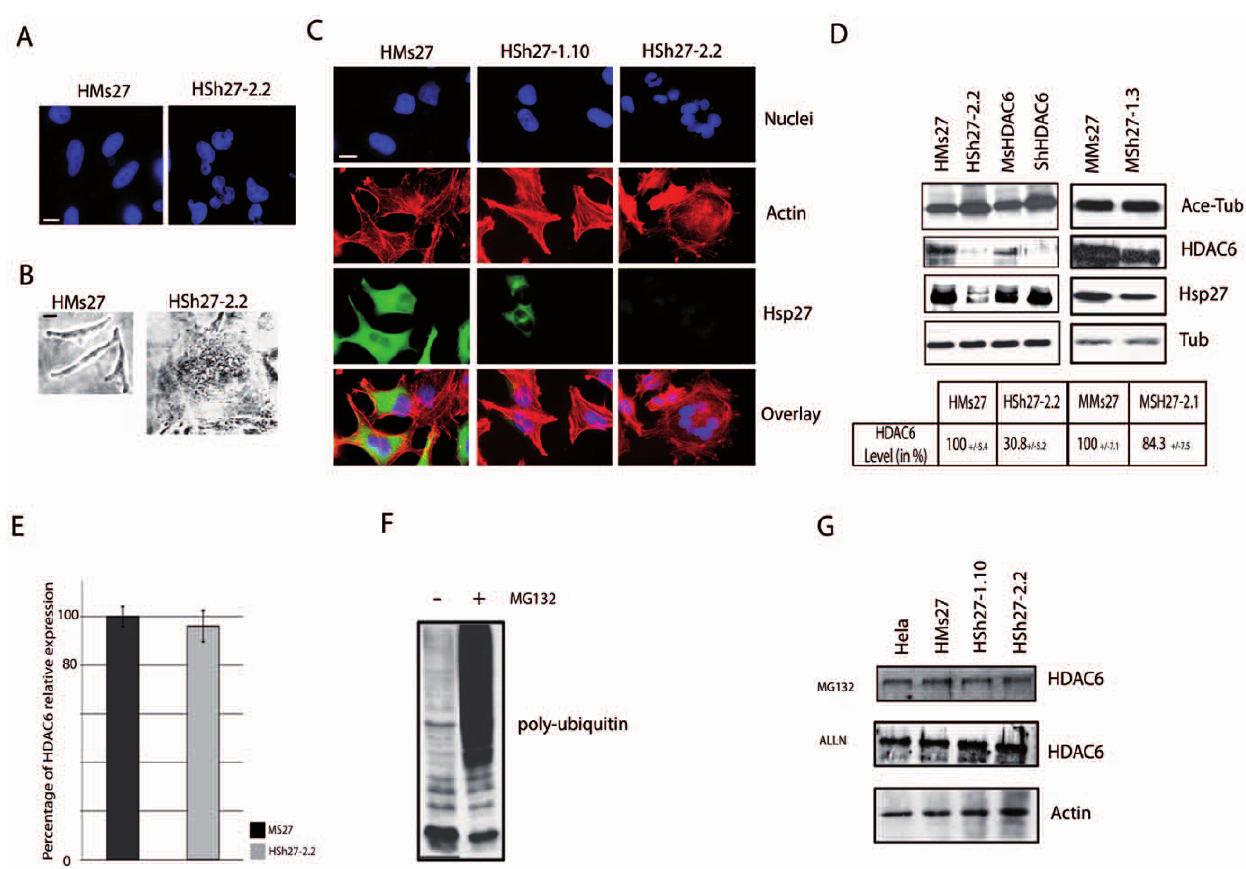
Figure 3. HDAC6 is degraded in Hsp27 deficient cell lines. A , photographs of nuclei of Hsp27 depleted HeLa cells stained by Hoechst. B , phase contrast pictures of a depleted HeLa clone showing a giant cell containing more than twenty nuclei. Bar=10 m m. C , Fluorescence photomicrographs analysis of Hsp27 and F-actin. HeLa cells were plated on glass cover slips and allowed to enter exponential growing phase for one day. Thereafter, cells were fixed and exposed to Hsp27 mouse monoclonal antibody followed by a goat anti-mouse FITC-conjugated antibody. Cells were also treated with TRITC-labeled phalloidin to visualize F-actin and with Hoechst to detect nuclei. Cells were then examined under a fluorescent microscope and photomicrographs including overlay analysis were recorded. Note the drastic modification of cells morphology induced by Hsp27 withdrawal. Bar=10 m m. D , Transient transfection with ShRNA-HDAC6 and MsRNA-HDAC6 encoding vectors as a control of tubulin induced hyperacetylation. Cell samples were collected and analyzed by immunobloting probed with the indicated antibodies. Quantification of western blot was reported on a table. E , quantification of hdac6 gene relative expression by qPCR analysis. F , proteasome activity, blocked by a low dose of MG132 (0.5 m mol/l- 20 hours), inversely correlates with poly-ubiquitin accumulation, as revealed by immunoblot analysis. Cells were submitted to 20 h treatments with